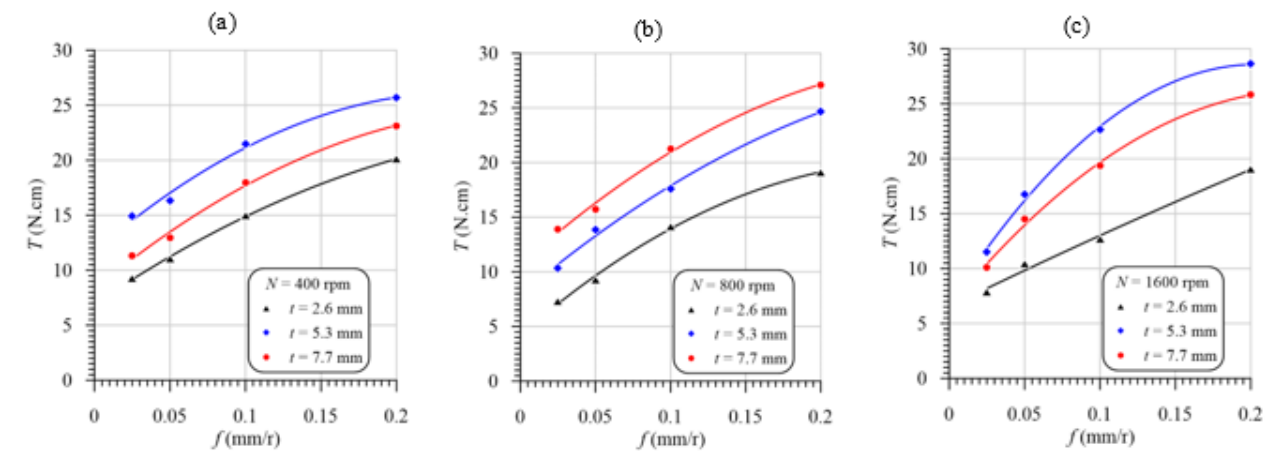
Figure 12. Torque vs. feed at different laminate thicknesses and speeds of ( a ) 400 rpm, ( b ) 800 rpm, and ( c ) 1600 rpm.